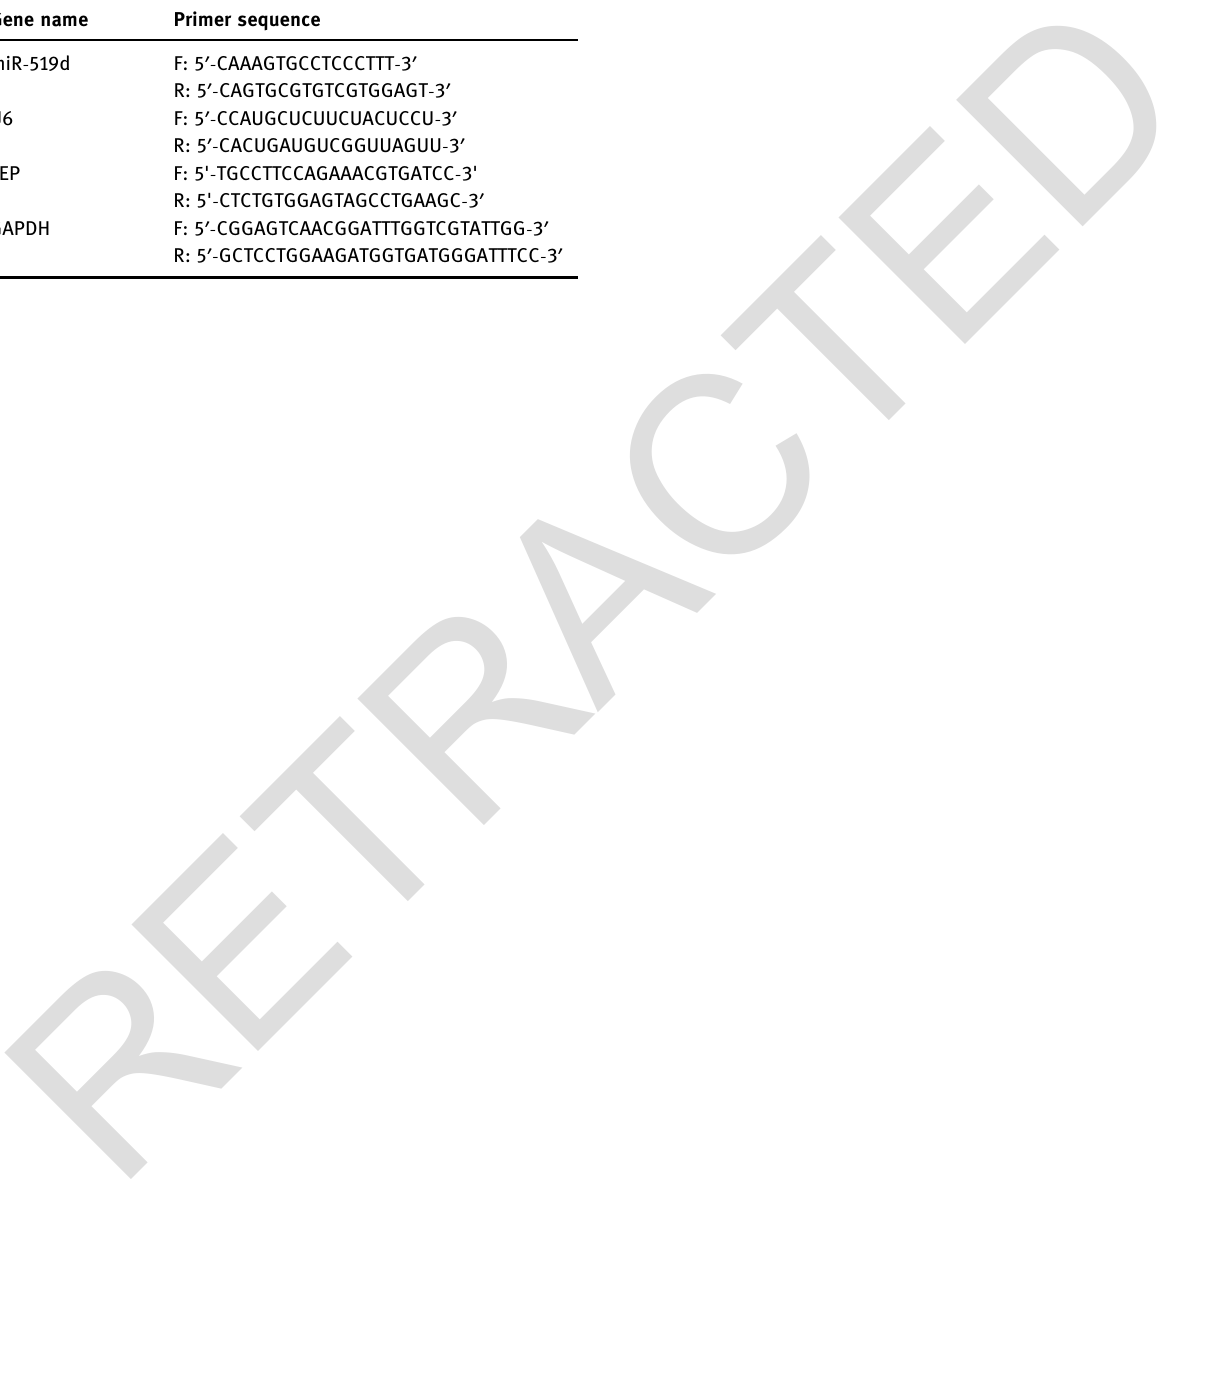
Table S1: Primer sequences used for RT -